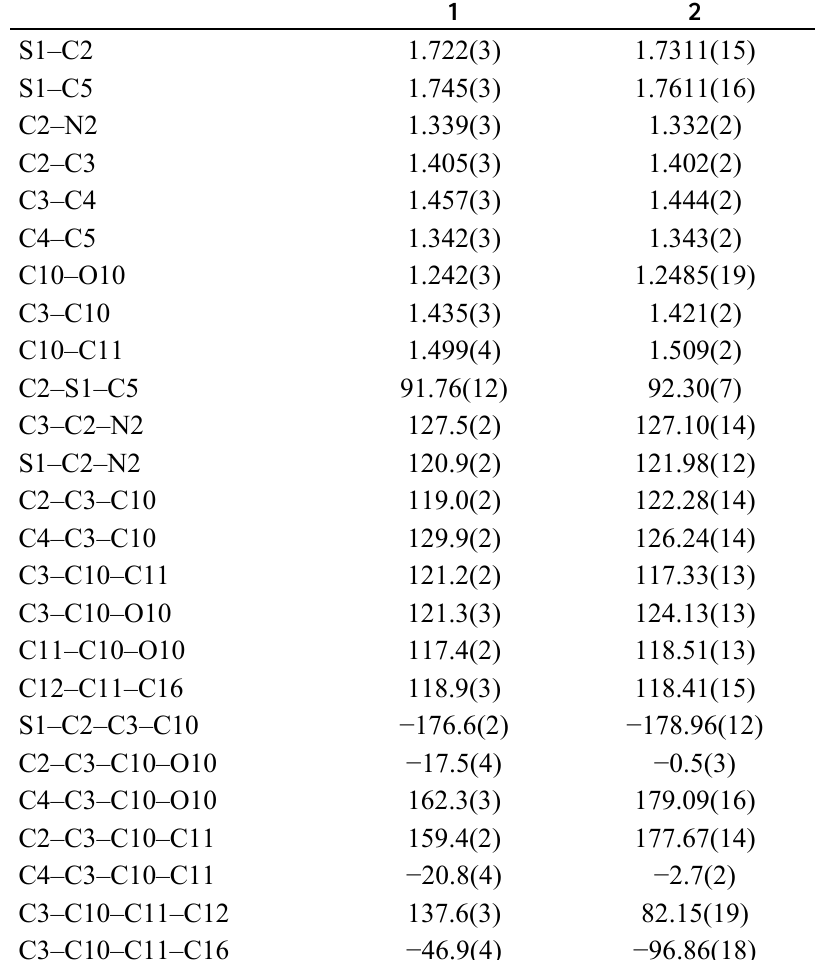
Table 1. Relevant geometrical features (Å, °) with esd’s in